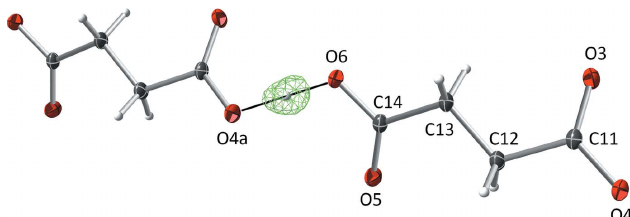
Figure 6 Difference-Fourier electron-density map for the region of the hydrogen atom situated close to the donor–acceptor midpoint in the short O— H (cid:2)(cid:2)(cid:2) O hydrogen bond [thin black line, O (cid:2)(cid:2)(cid:2) O = 2.4367 (1) A˚ ] linking the hydrogen succinate cations into chains propagating parallel to the b -axis in I .